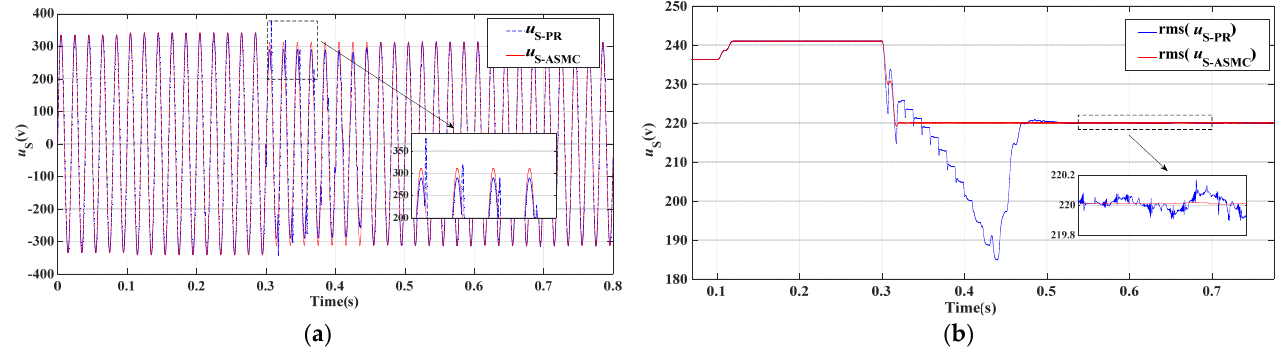
u under ASMC and PR control when ES works in inductive mode: ( a ) Figure 6. Comparison of Figure 6. Comparison of u S under ASMC and PR control when ES works in inductive mode: S waveform comparison, ( b ) RMS comparison. ( a ) waveform comparison, ( b ) RMS